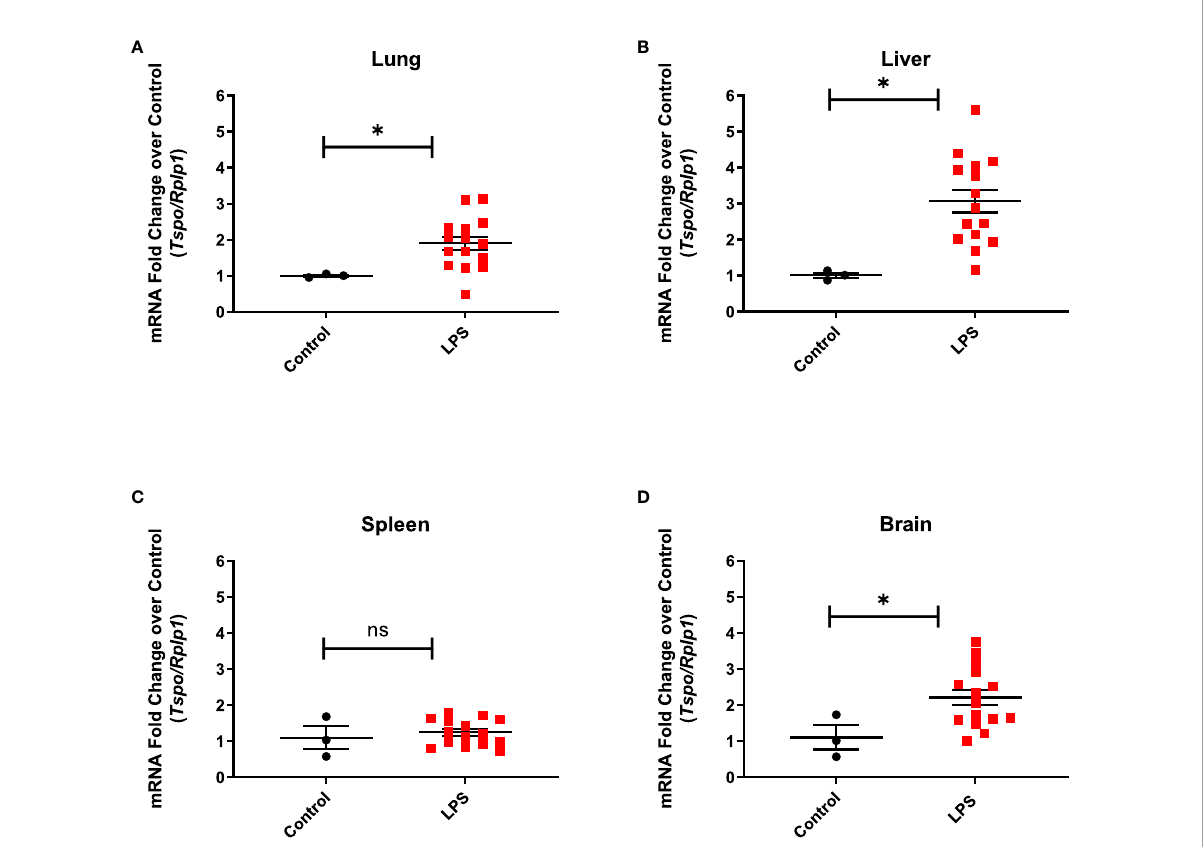
FIGURE 5 TSPO gene expression in organ lysates. Increased TSPO mRNA levels in the lung. (A) (p=0.0497), liver (B) (p=0.0121), and brain (D) (0.0462) from LPS treated rats (n=15), but not in the spleen (C) (p=0.5529), when compared to controls (n=3). Statistical analysis was performed using unpaired t-test. Mean with SEM are shown. p-values <0.05 are considered statistically signi fi cant. Tspo is target gene and ribosomal protein lateral stalk subunit P1 (Rplp1) is the housekeeping gene used for normalization. *p<0.05; not signi fi cant